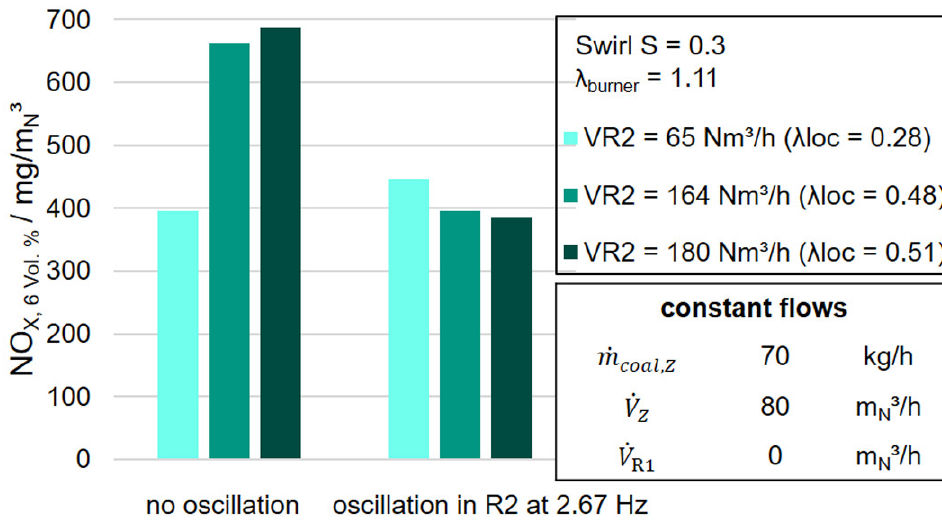
Figure 10. Investigation of the oscillated air flow.